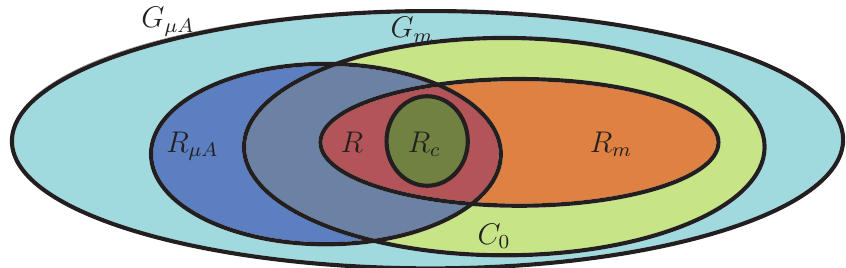
Figure 3: Representation of the possible intersections between G µA (the set of genes with a spot on the microarray), G m (the set of genes considered in the model), R µA (the set of microarray regulated genes) and R m (the set of in silico regulated genes) assuming G m ⊆ G µA .